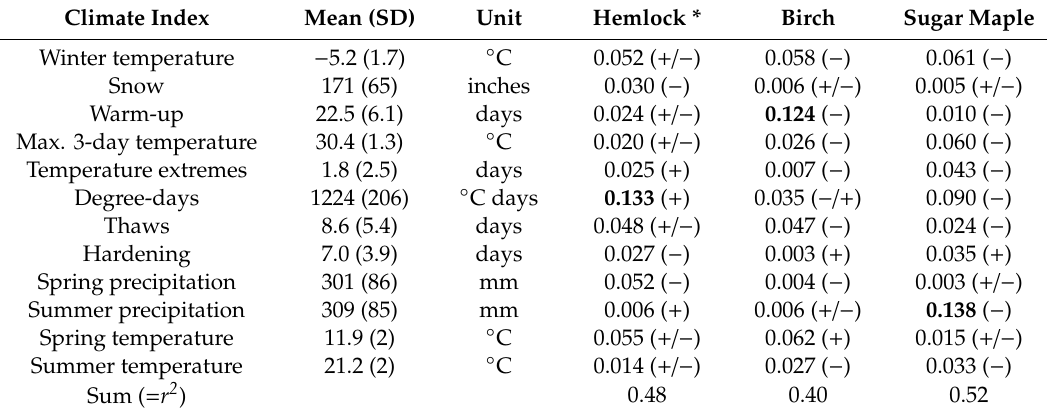
Table 1. Relative importance of climate indices in explaining ring width index of three mixed northern hardwood species from 1977–2011; the sum of importance values is equal to the coe ffi cient of determination ( r 2